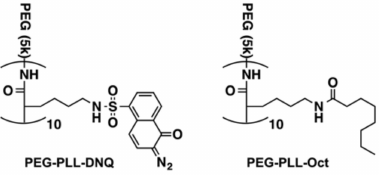
Figure 1. Structure of PEG-PLL-DNQ and PEG-PLL-Oct.